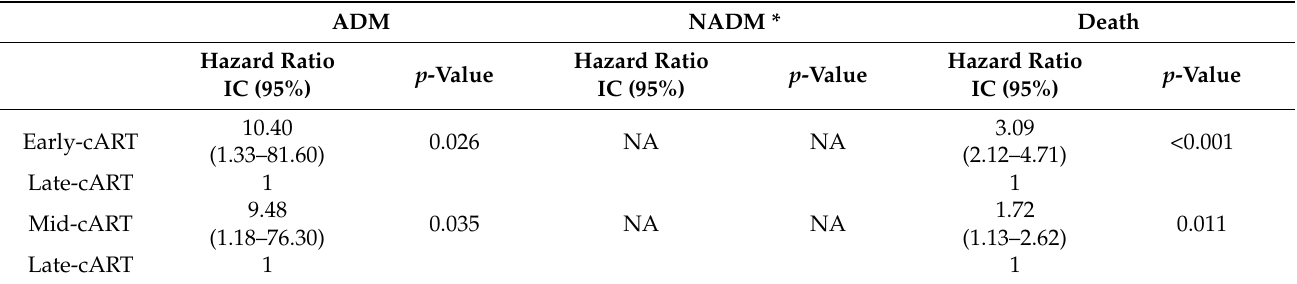
Table 4. Hazard Ratio (HR) for Death not related to Lymphoma or for ADM or NADM development between Eras (Competing Risk